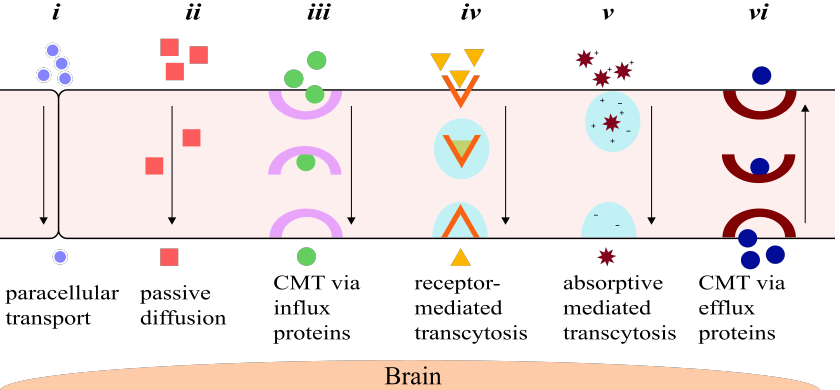
Figure 1. A schematic representation of the six major ways drugs and other molecules travel across the blood–brain barrier: ( i ) paracellular transport between the tight junctions between the endothelial cells by small, hydrophilic molecules; ( ii ) passive diffusion through the endothelial cells of small lipophilic drugs; ( iii ) carrier-mediated transport of larger lipophilic molecules by influx carrier proteins; ( iv ) receptor-mediated transcytosis of larger molecules with affinity towards specific receptors; ( v ) absorptive-mediated transcytosis of large, cationic molecules by binding and ultimately absorbing into the luminal surface of the endothelial cell; and ( vi ) transport of unwanted molecules back into systemic circulation by efflux